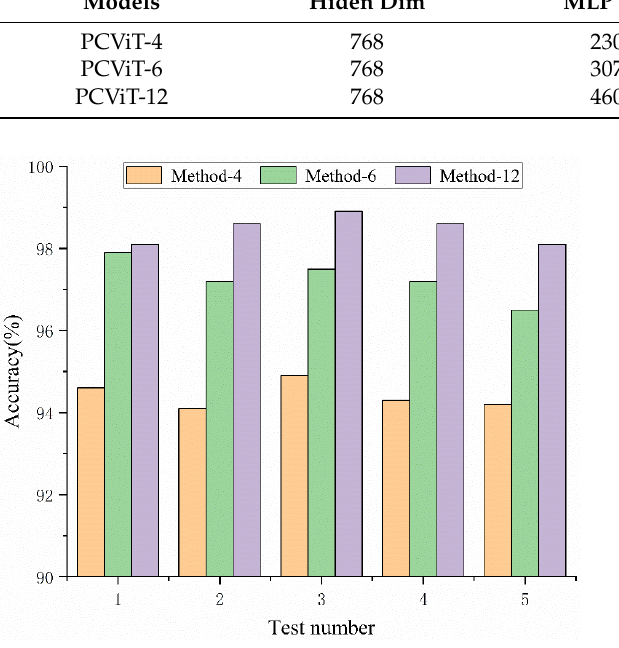
Figure 10. The recognition accuracy of the PCViT network with different depths.